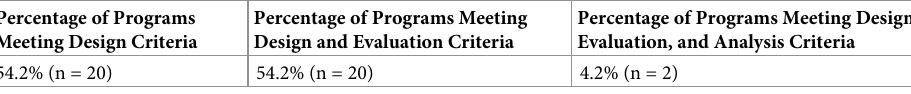
Table 2. Percentage of reviewed articles that met the selected criteria (N =